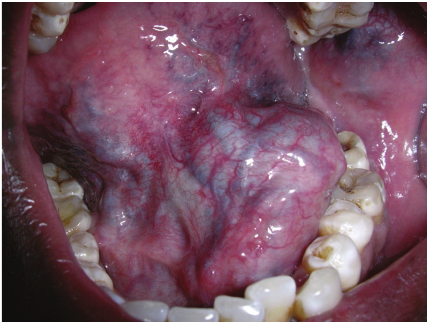
Figure 1: Intraoral photograph showing swelling with bluish discol- oration in floor of the mouth with intact overlying mucosa.